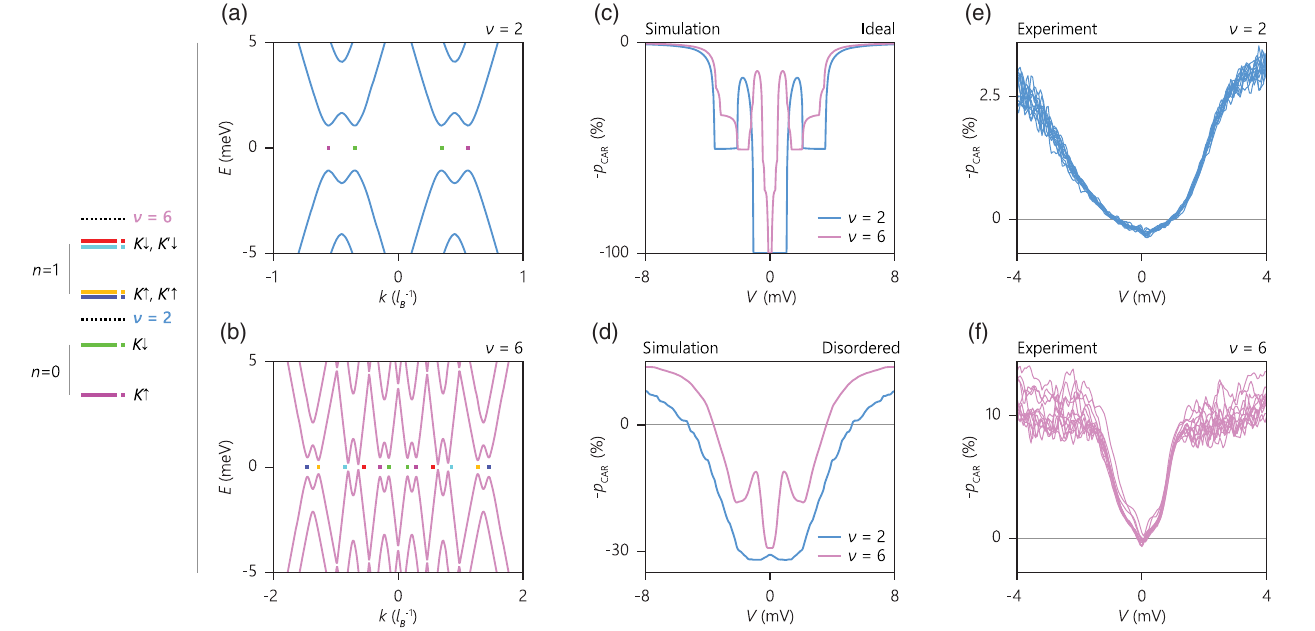
FIG. 19. Bogoliubov – de Gennes spectrum, calculated CAR response, and transport spectroscopy in device 1 for ν ¼ 2 and 6. (a),(b) Bogoliubov – de Gennes spectrum of ν ¼ 2 and 6 calculated using 2D simulations. Hybridization of the inner edge modes (those from lower Landau levels) is stronger due to their closer proximity to the superconductor, leading to larger gaps around k for which band crossings occur. Colored squares indicate the Landau levels whose edge modes hybridize. (c),(d) CAR response calculated using the effective edge theory in the ideal and the disordered case. For the clean case, CAR asymptotically vanishes at high energies. Including > 0 . This implies that the pairing gap and disorder together determine the energy range disorder limits the energy range for which p CAR of CAR in a realistic setup. We note that in the presence of disorder, p turns negative (i.e., R becomes positive) at a bias voltage CAR CAR much larger than the energy scale of Δ due to direct tunneling processes dominating at higher energy. The parameters used in the ind ¼ 1 . 2 ε ν ¼ 6 ). effective theory are extracted from the 2D simulations for which the system parameters are the same as in Fig. 7 ( μ 0 for n (e),(f) p at ν ¼ 2 and 6 as a function of the incoming edge mode potential V (excitation) for different gate voltages spanning the CAR entire QH plateau region. CAR is limited to below j e V j ∼ 1 meV for ν ¼ 2 and below j e V j ∼ 0 . 2 meV for ν ¼ 6 . (a) Same as in Fig. 2 (d). (e),(f) Same as Figs. 2(e) and